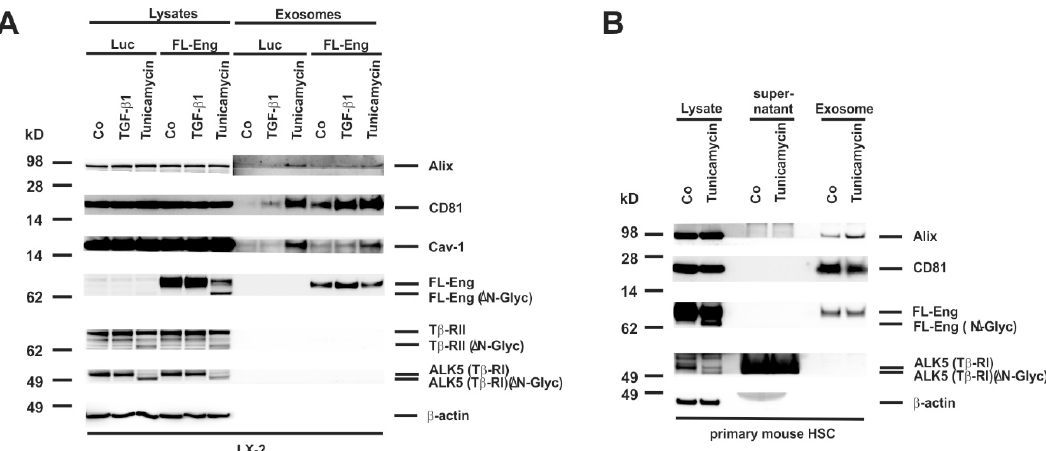
Figure 8. Isolation of exosomes from HSC treated with tunicamycin. ( A ) Cell extracts or exosome fractions prepared from LX-2 which were infected with FL-Eng or a control virus expressing luciferase (Luc). Subsequently, the cells were treated with TGF- β 1 or an inhibitor of N -glycosylation (tunicamycin) and analysed by Western blot for expression of indicated proteins. Please note, that only properly glycosylated Eng is directed to the exosomal compartment. ( B ) Cell protein extracts, supernatants, and exosomes were prepared from primary mouse HSC and analysed for the presence of indicated proteins demonstrating that endogenous Eng is only directed to exosomes when properly